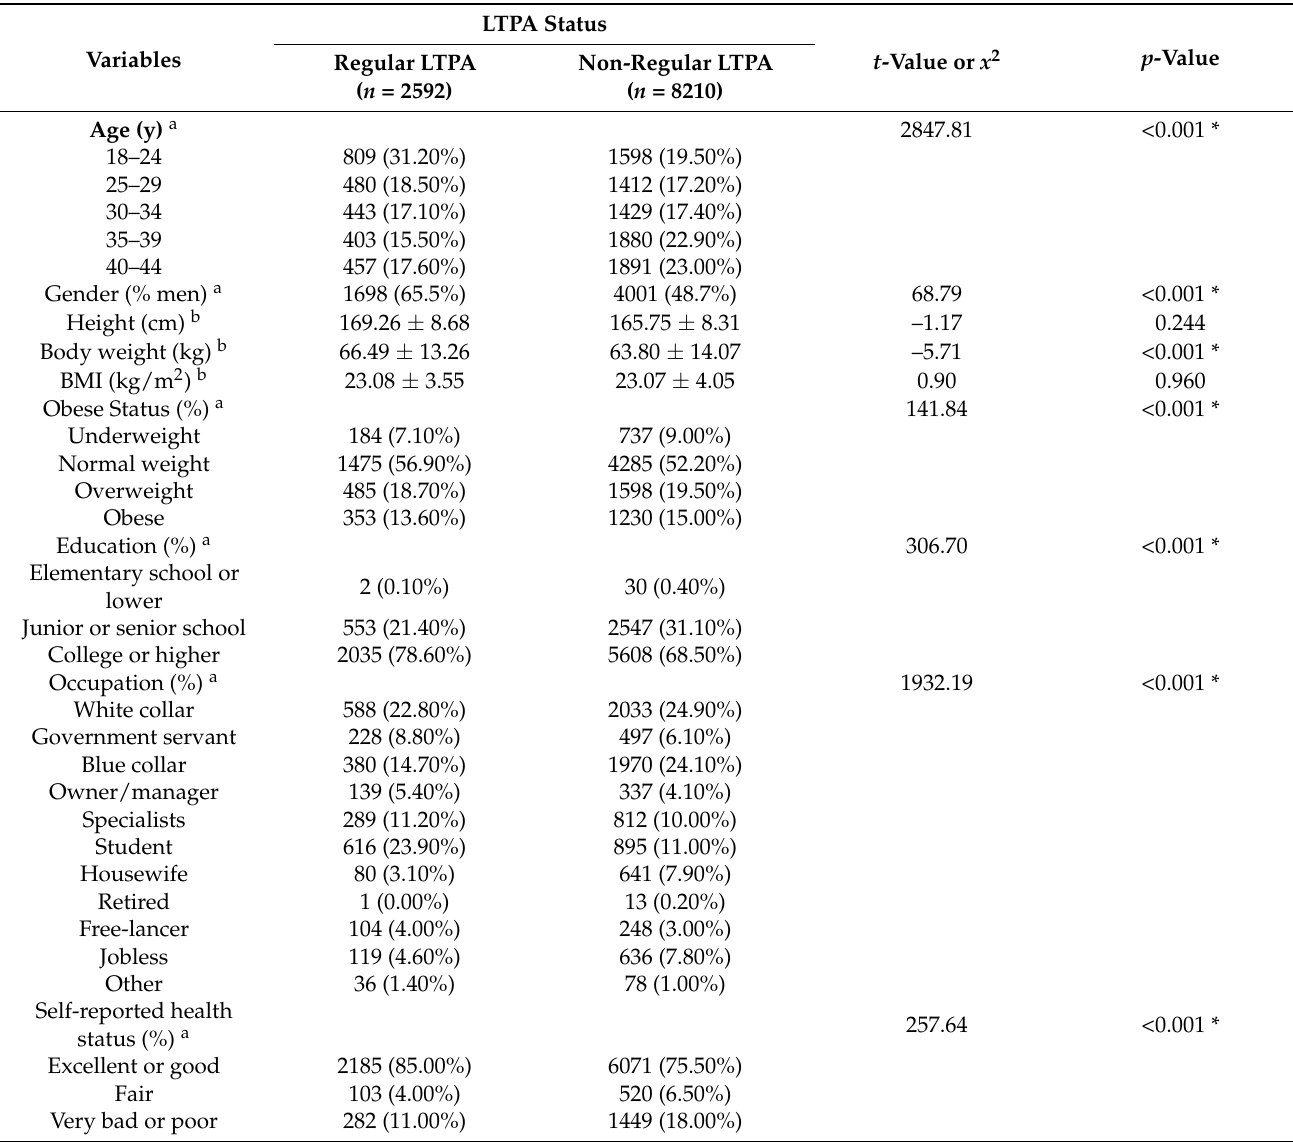
Table 1. Demographic characteristics.